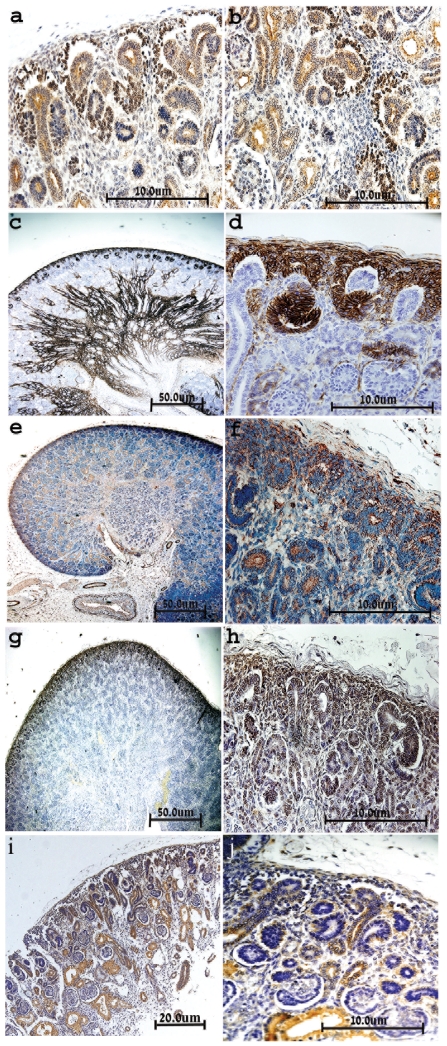
Immunostaining of putative stem cell markers.(a–j) Representative immunostaining of SIX2, NCAM1, FZD7, ACVR2B and NTRK2 in paraffin embedded sections of HFK (12, 13 and 18 weeks of human gestation); (a–b) localization of SIX2 to the MM, predominantly to the CM. (c–d) predominant staining of NCAM1 in the MM (including CM) and its derivatives (S- and comma- shaped bodies) and renal stroma, but not mature tubules or UBs. (e–f) FZD7 demonstrates preferential localization to the nephrogenic zone including MM and its derivatives, UBs, and newly forming tubules but not the stroma. (g–h) ACVRIIB immunostaining demonstrates predominant expression in the nephrogenic cortex; MM and its derivatives (S and comma shaped bodies), UBs, parietal epithelium of fetal glomeruli but not in the stroma. (i–j) NTRK2 is detected in the MM (including condensates) and its derivatives, UBs and some differentiated tubules. Figures c, e and g are shown in low magnification (original×4), Figures a, b, d, f and h–j are shown in higher magnifications (original×40; I, original×20).